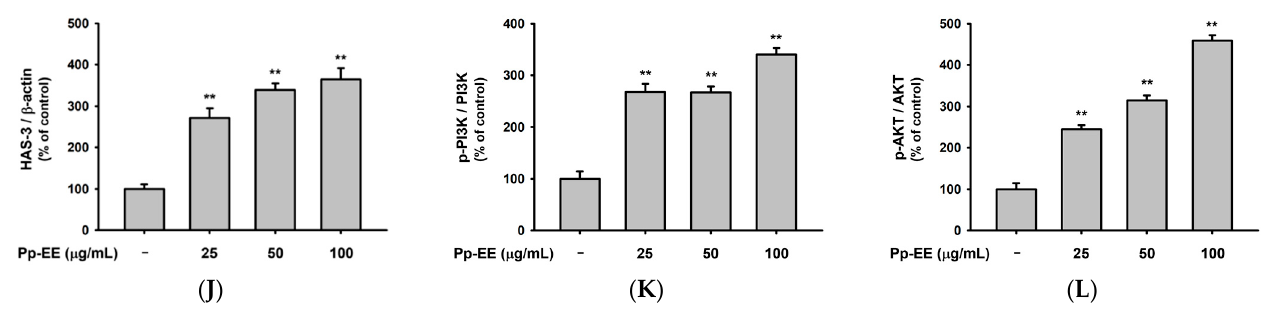
Figure 3. Effects of Pp-EE on parameters that can affect skin moisture. ( A – G ) The mRNA levels of HAS-1 , HAS-2 , HAS-3 , Hyal-1 , Hyal-2 , Hyal-3 , and Hyal-4 in Pp-EE-treated HaCaT cells were determined by quantitative real-time PCR. The fold increase represents the ratio of the increased mRNA expression level of Pp-EE-treated groups to the mRNA expression level of the normal group. ( H ) The total and phosphorylated forms of PI3K, AKT, HAS-2, and HAS-3 were measured using immunoblotting analysis. ( I – L ) The relative intensities of the immunoblots were determined using ImageJ. All results are expressed as the mean ± standard deviation. * p < 0.05, ** p < 0.01 compared with the normal group.